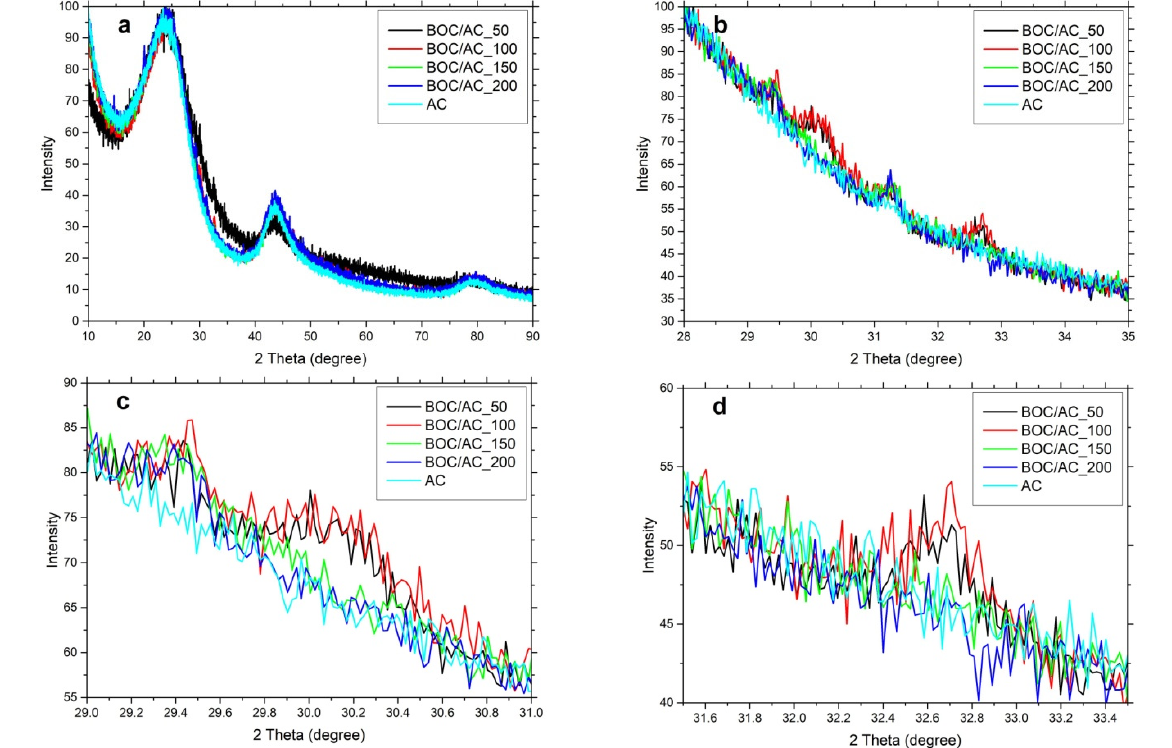
Figure 6. XRD patterns ( a ) and enlarged local XRD patterns ( b – d ) of the as-synthesized BOC/AC and AC.